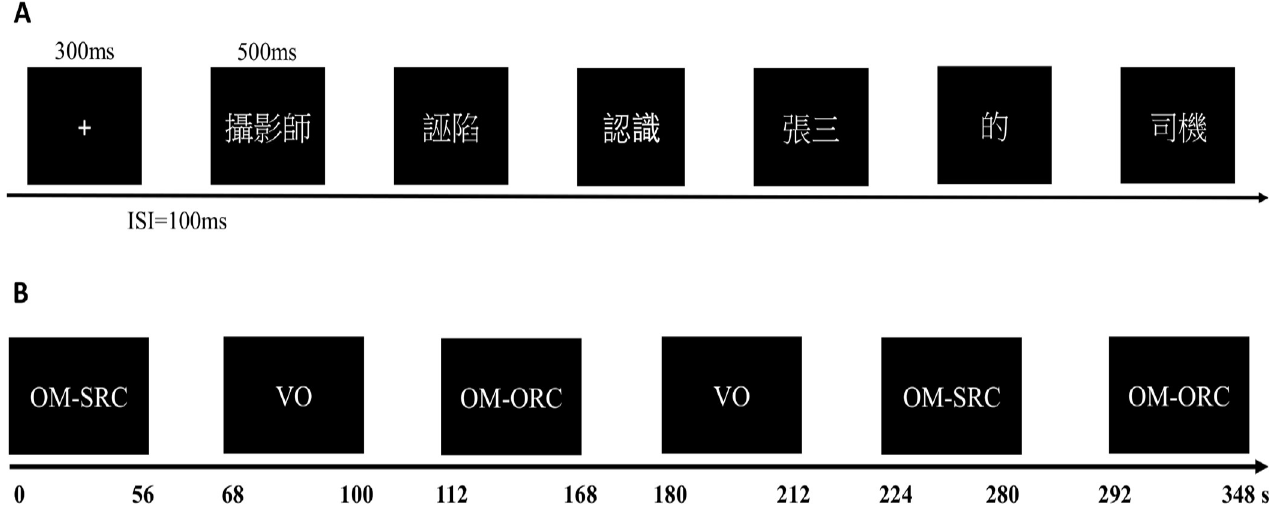
Fig 1. Experimental procedure. (A) The timeline of one sentence trial. Each trial starts with a fixation cross presented for 300 ms, followed by a 100 ms blank. Six frames are successively presented on the screen for 500 ms with 100 ms inter-stimulus interval. (B) The timeline of one run in the experiment. Each run contains six blocks, with two blocks of each type of sentences (OM-SRC and OM-ORC) and two blocks of the baseline condition (VO). The blocks in each run are in a pseudorandomized order. Note: VO = visual orientation; OM-SRC = object-modifying subject-extracted relative clause; OM-ORC = object-modifying object-extracted relative